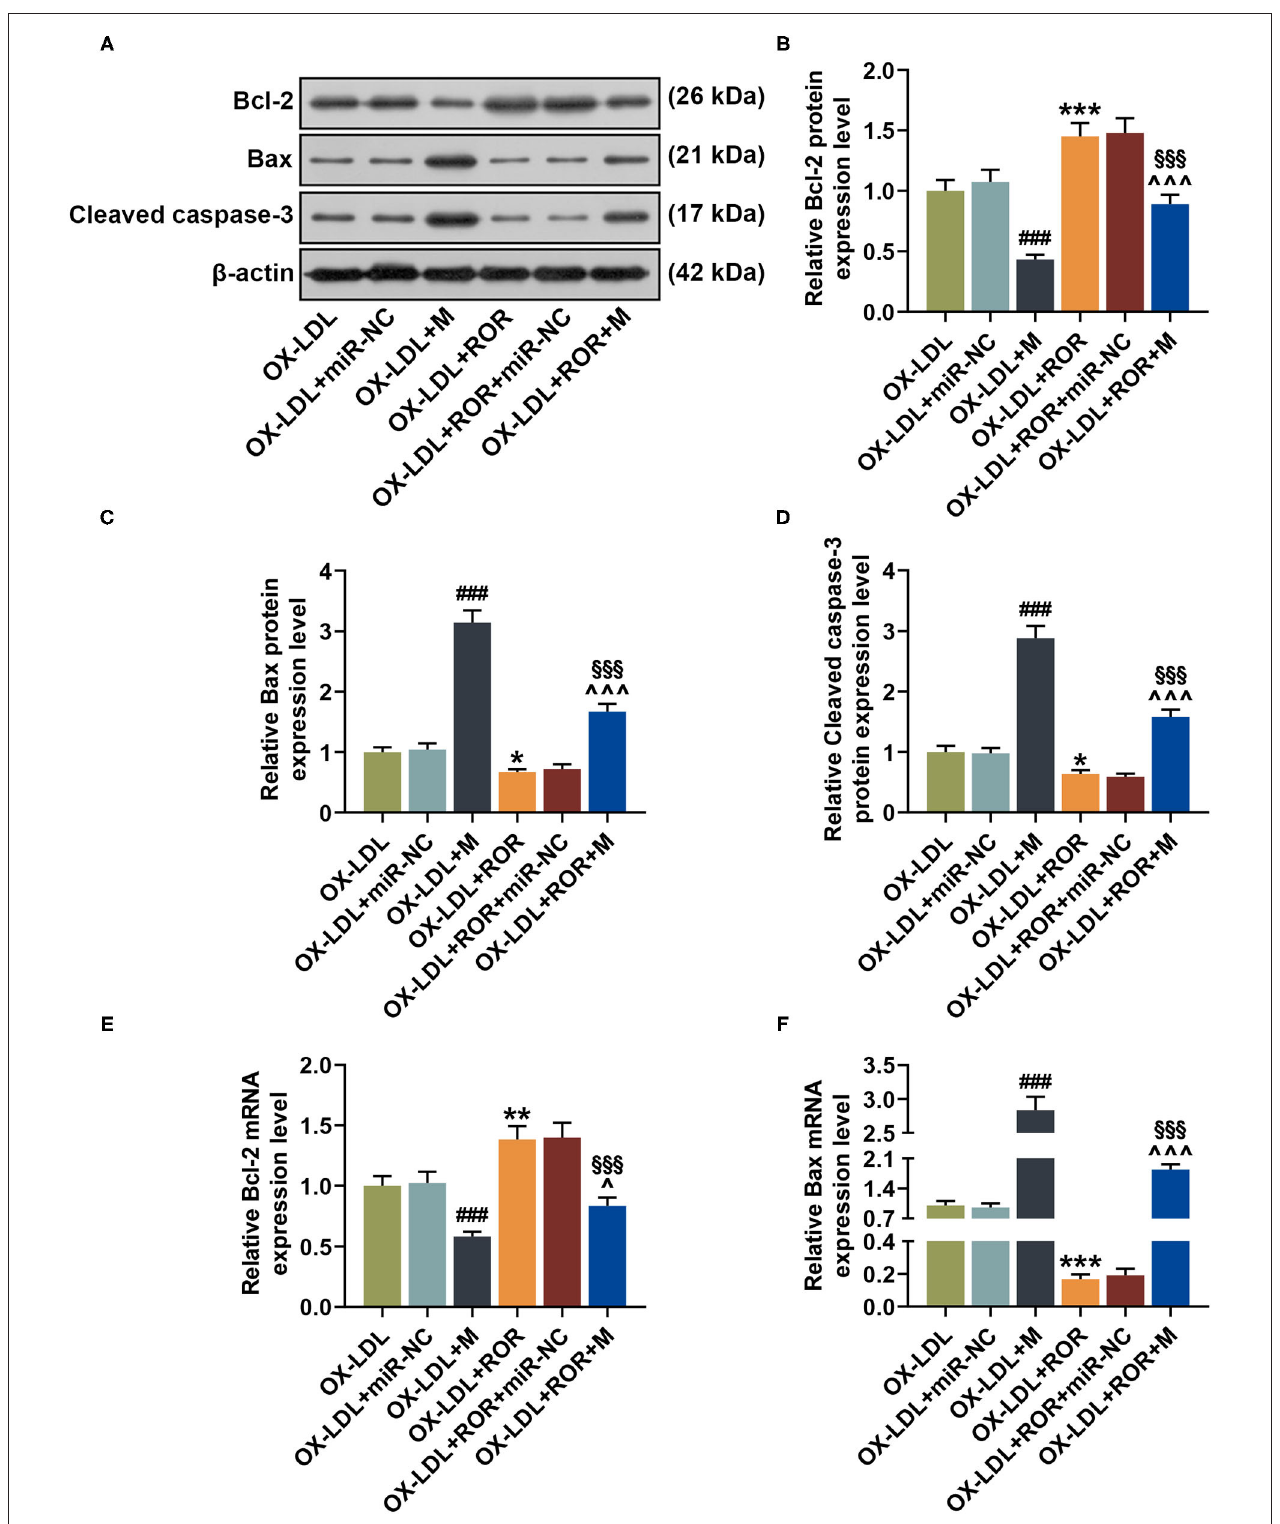
FIGURE 4 | let-7b-5p reversed the effects of the upregulation of lncRNA regulator of reprogramming (ROR) on apoptosis-related protein expressions. (A–D) The relative protein/ β -actin expressions of Bcl-2 (B) , Bax (C) , and cleaved caspase-3 (D) were measured by Western blot. β -Actin was used as an internal